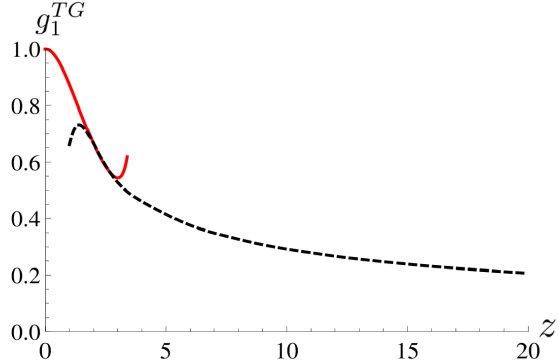
in the Tonks-Girardeau regime as 1